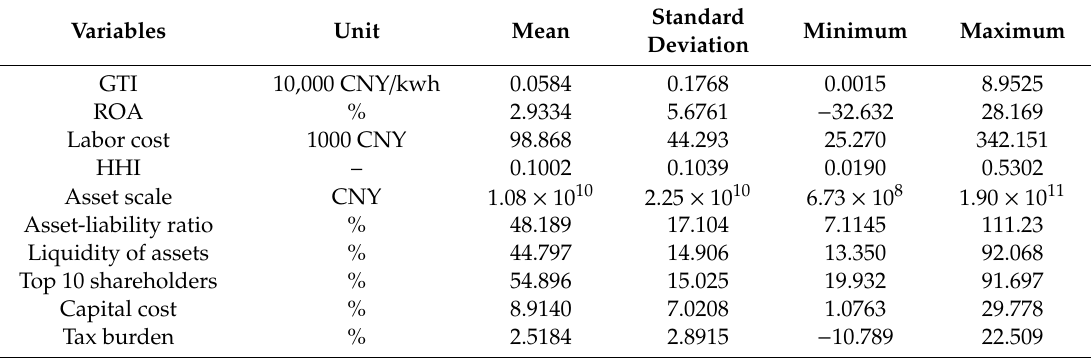
Table 2. Description of variables and statistics. GTI: green technological innovation; ROA: return on assets; HHI: Herfindahl–Hirschman Index.